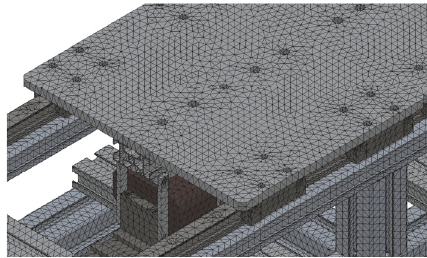
Figure 6: Partial detail view of the resultant mesh